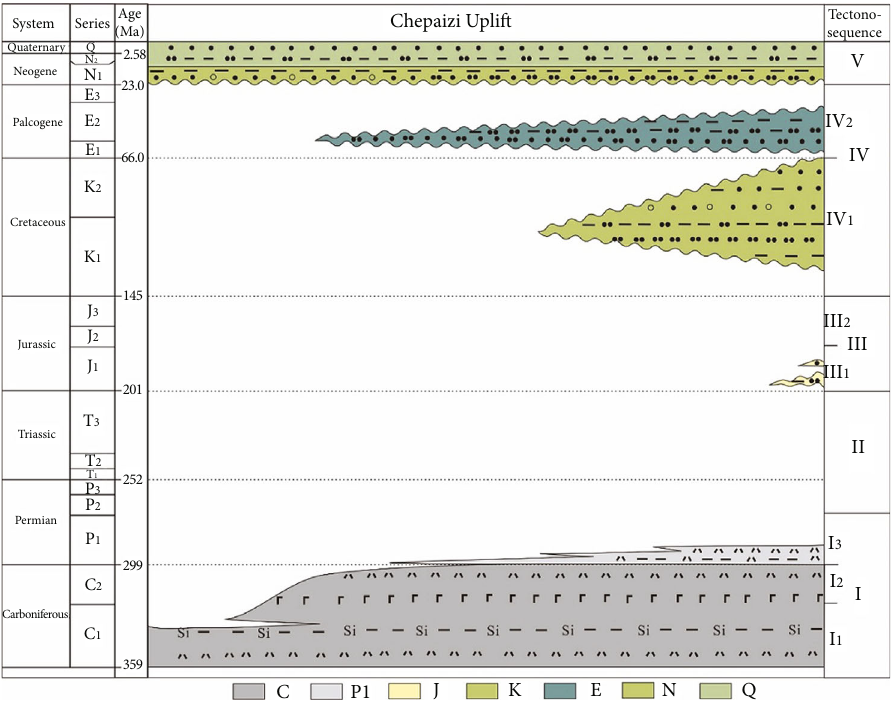
Figure 5: Tectonic stratigraphic sequence analysis of the Chepaizi